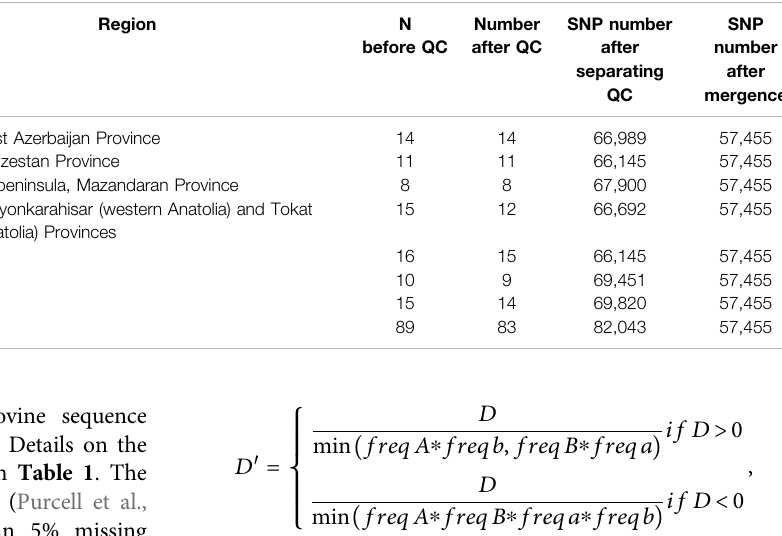
TABLE 1 | Descriptive statistics for the studied buffalo